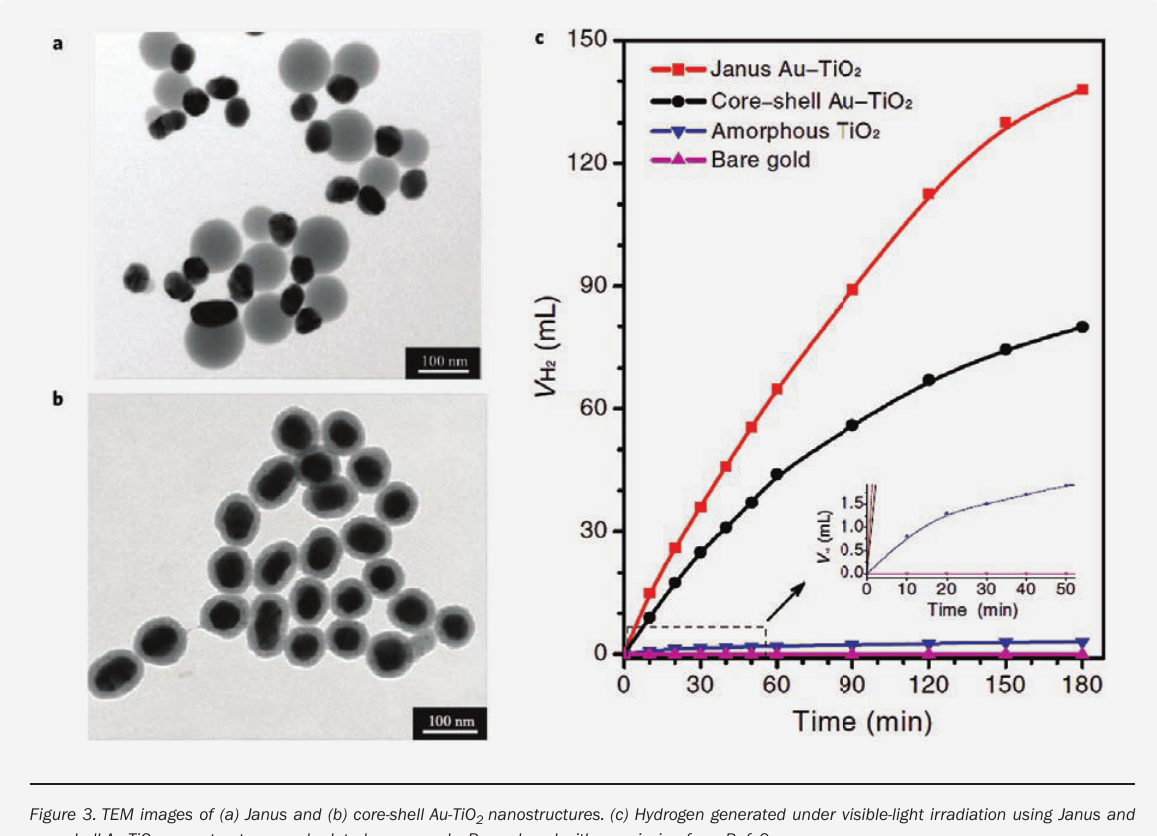
Figure 3. TEM images of (a) Janus and (b) core-shell Au-TiO 2 nanostructures. (c) Hydrogen generated under visible-light irradiation using Janus and core-shell Au-TiO 2 nanostructures and related compounds. Reproduced with permission from Ref. 9.